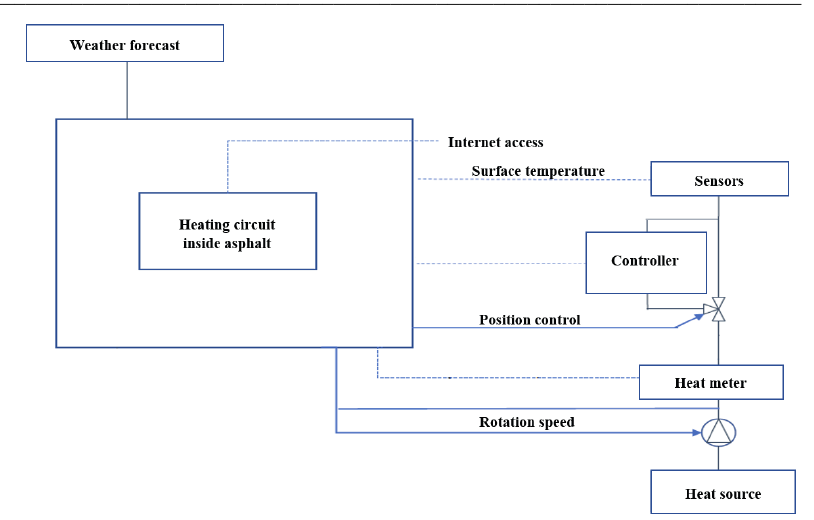
Fig. 1. Schematic of hydronic road heating